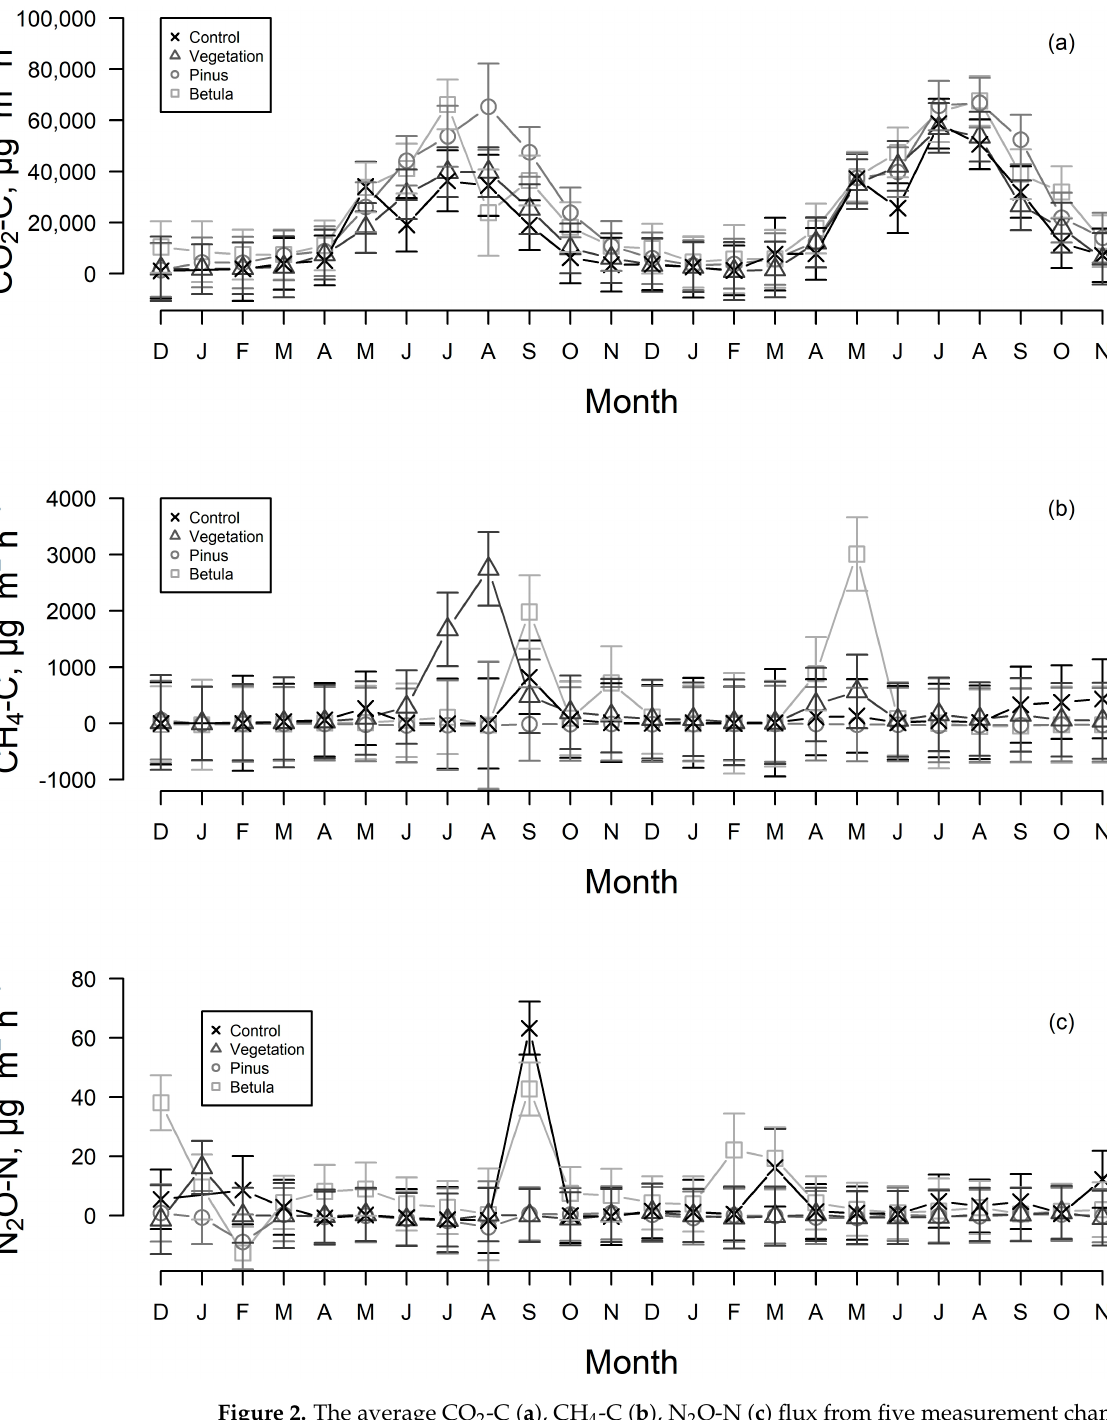
Figure 2. The average CO 2 -C ( a ), CH 4 -C ( b ), N 2 O-N ( c ) flux from five measurement chambers per measurement month and land use type.